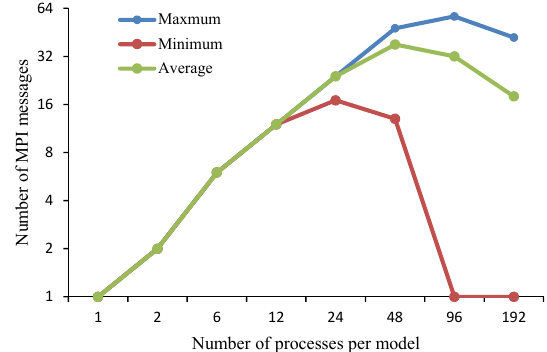
Figure 4. Variation of the number of MPI messages of one process ( y axis) using the P2P implementation in GAMIL2–CLM3 with re- spect to the number of processes per model ( x axis). The experi- mental set-up is similar to that shown in Fig. 1.